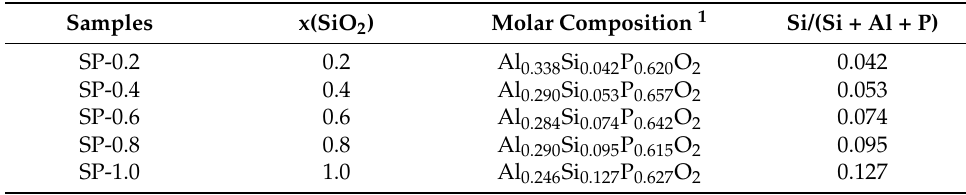
Table 1. Compositions of the as-synthesized samples.